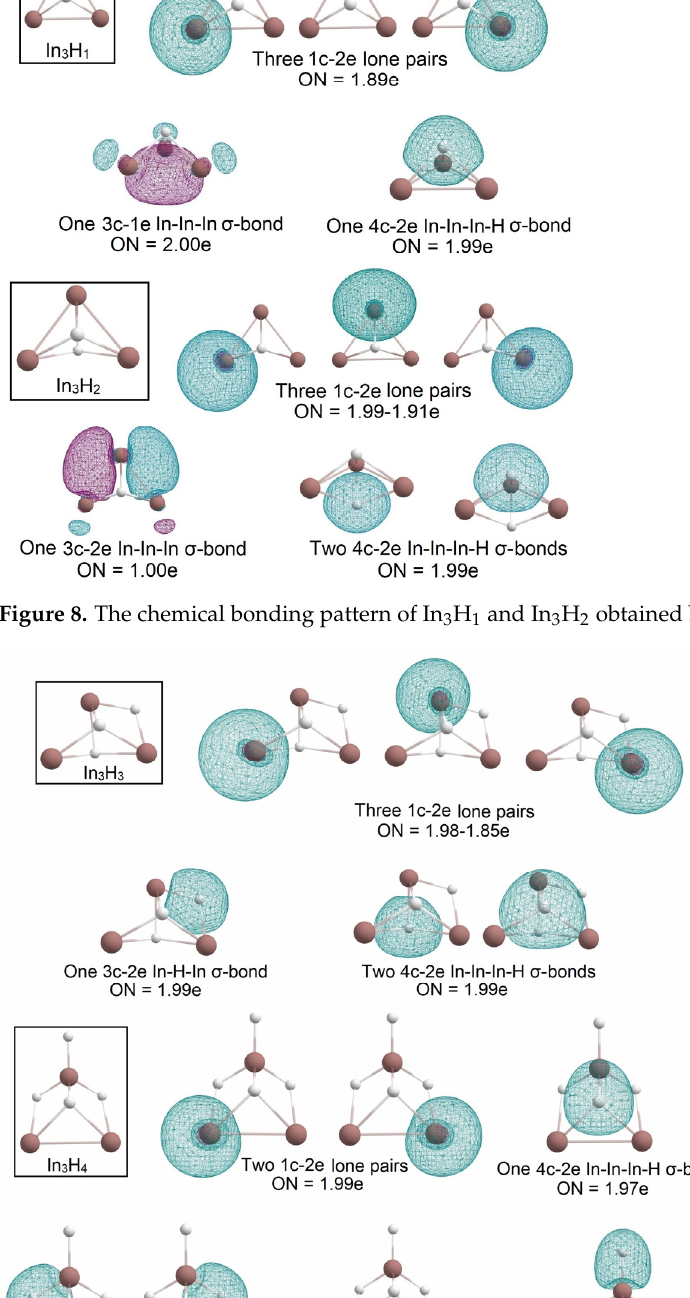
In σ -bond with ON = 1.00e; the AdNDP analysis reveals that it consists of two p x orbitals and one perpendicular p y orbital.